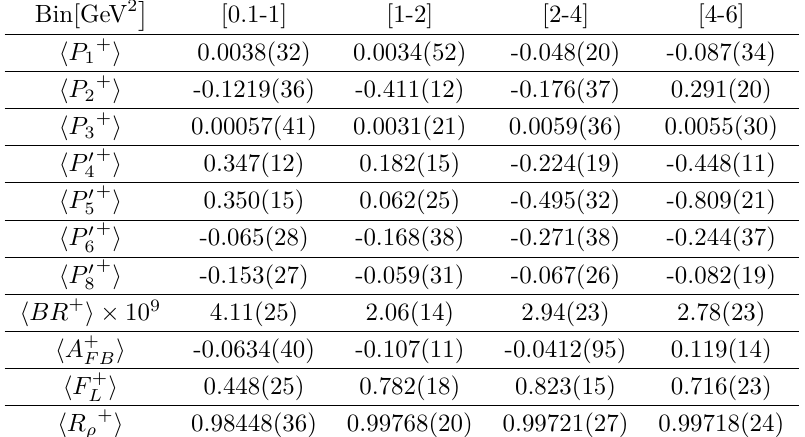
Table 9 . SM Predictions of observables for B + → ρ + ‘‘ .